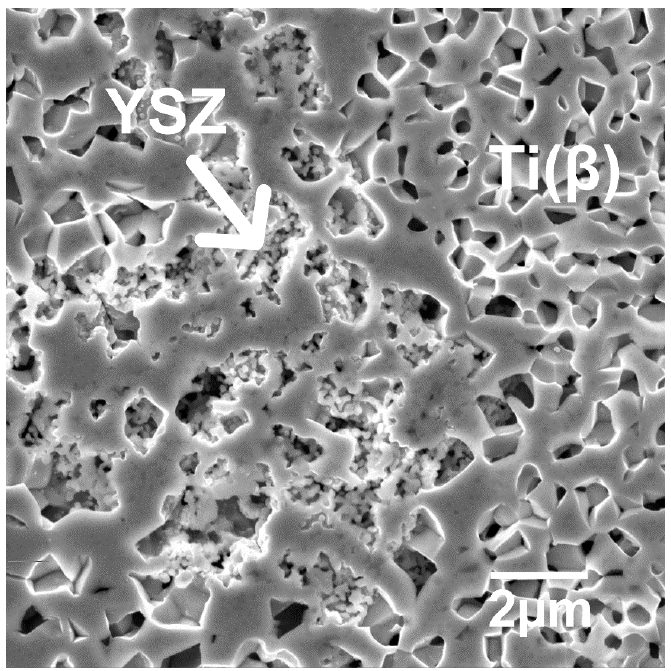
Figure 9. SEM microphotograph of the 35–10 specimen.